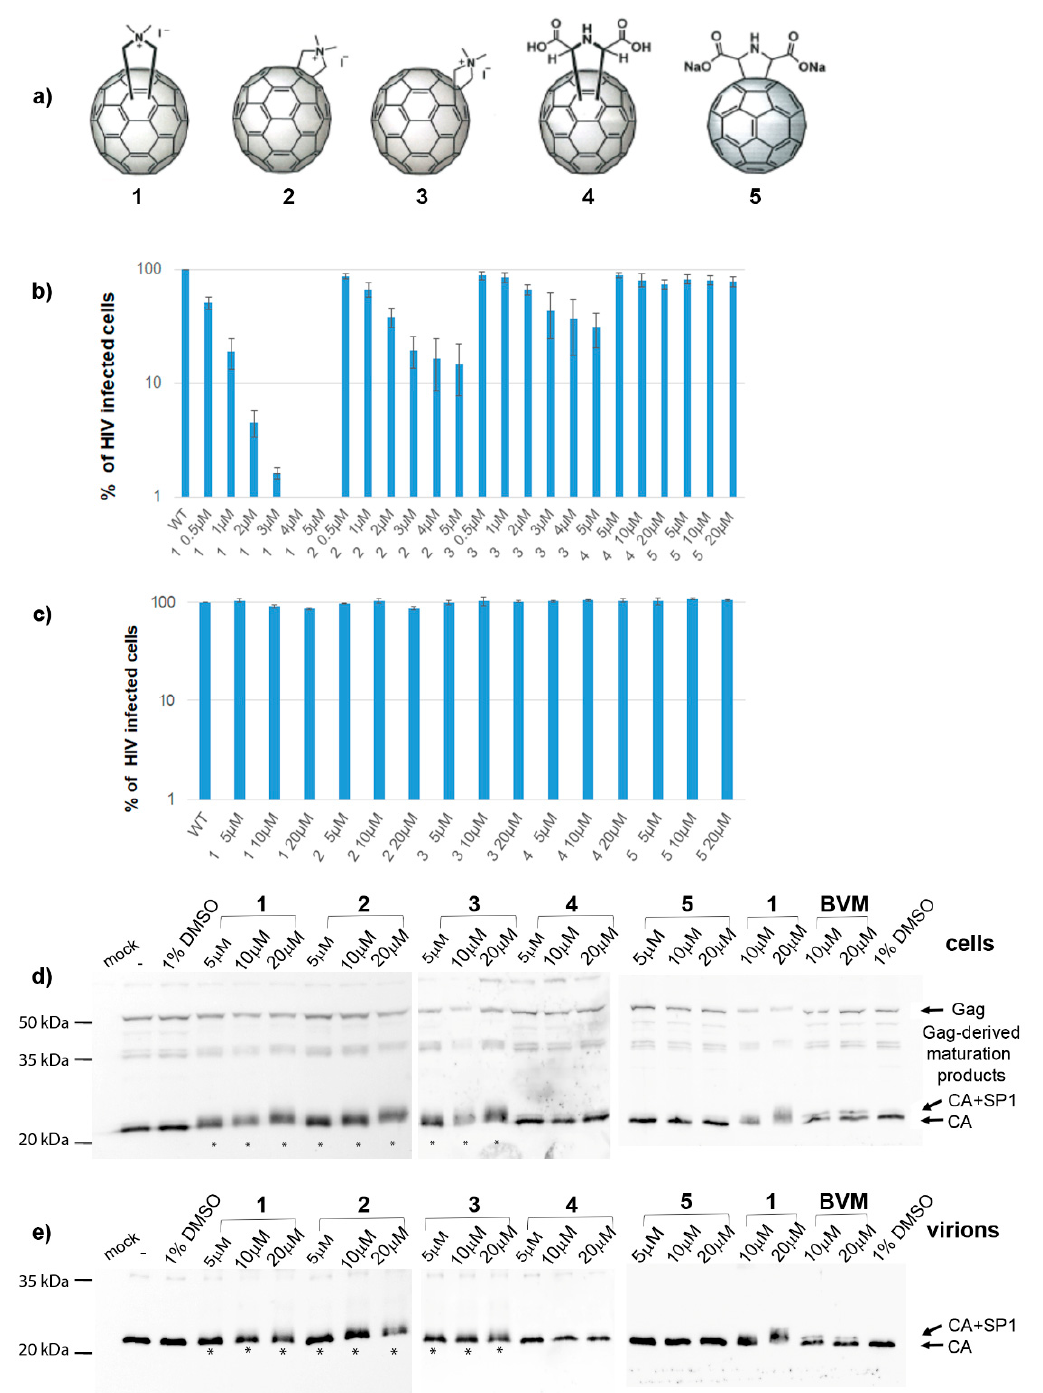
Figure 1. Fullerene derivatives and their effects on the HIV-1 life cycle. ( a ) Structures of fullerene derivatives 1-5. ( b ) HEK 293 cells produced VSV-G-pseudotyped GFP-HIV-1 in the presence of DMSO or fullerene derivatives at indicated concentrations. At 48 h post-transfection, a normalized amount of the VSV-G pseudotyped GFP-HIV-1 released into the culture media was used for infection of fresh HEK 293 cells, and 48 h later, the GFP-positive cells were quantified using a flow cytometer. ( c ) Effects of fullerenes on the early stage of HIV-1 life cycle. ELISA-normalized amounts of VSV-G pseudotyped GFP-HIV-1 viruses were used for infection of HEK 293 cells in the presence of DMSO or indicated concentrations of fullerene derivatives. Forty-eight hours later, the GFP-positive cells were quantified using a flow cytometer. ( d ) Immunoanalysis of intracellular VSV-G